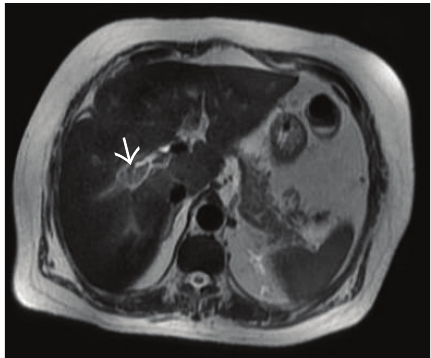
Figure 39: Axial T2-weighted MR image demonstrating mildly hyperintense thrombus (arrow) in the right portal